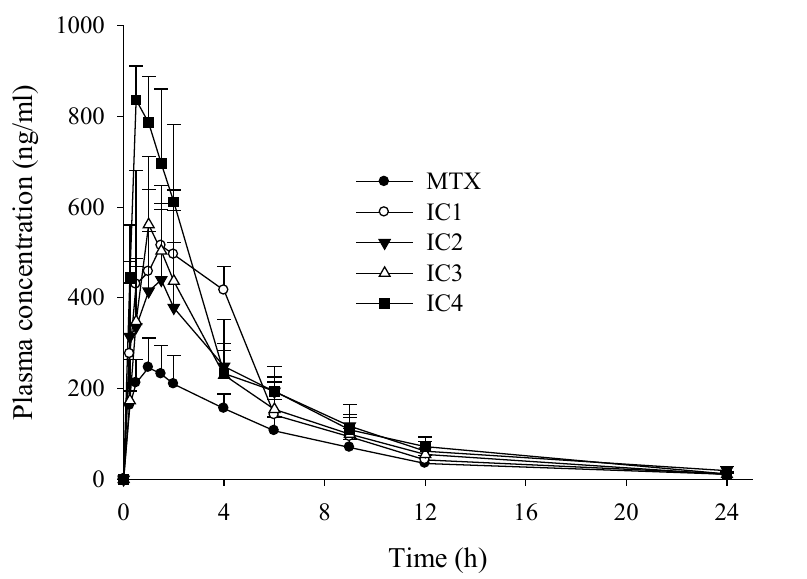
Figure 9. Plasma concentration–time profiles of MTX after oral administration of MTX and inclusion compounds in rats. Each value represents the mean ± S.D. ( n = 6).